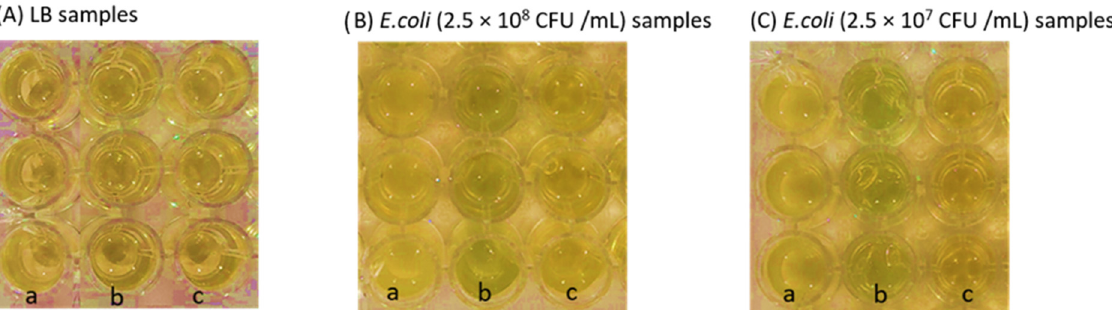
Figure 12 . Visual detection of E. coli in suspension (2.5 × 10 8 CFU/mL, and 2.5 × 10 7 CFU/mL) after incubation at 24 °C for 20 h. Photographs of the following samples in triplicates (vertical arranged wells are identical) are displayed: (a) no hydrogel (b) PUAA-ADH_X-Gluc films, (c) PUAA-ADH films. All samples were exposed to ( A ) LB, ( B ) E. coli (2.5 ×10 8 CFU/mL) and ( C ) E. coli (2.5 × 10 7 CFU/mL), respectively.